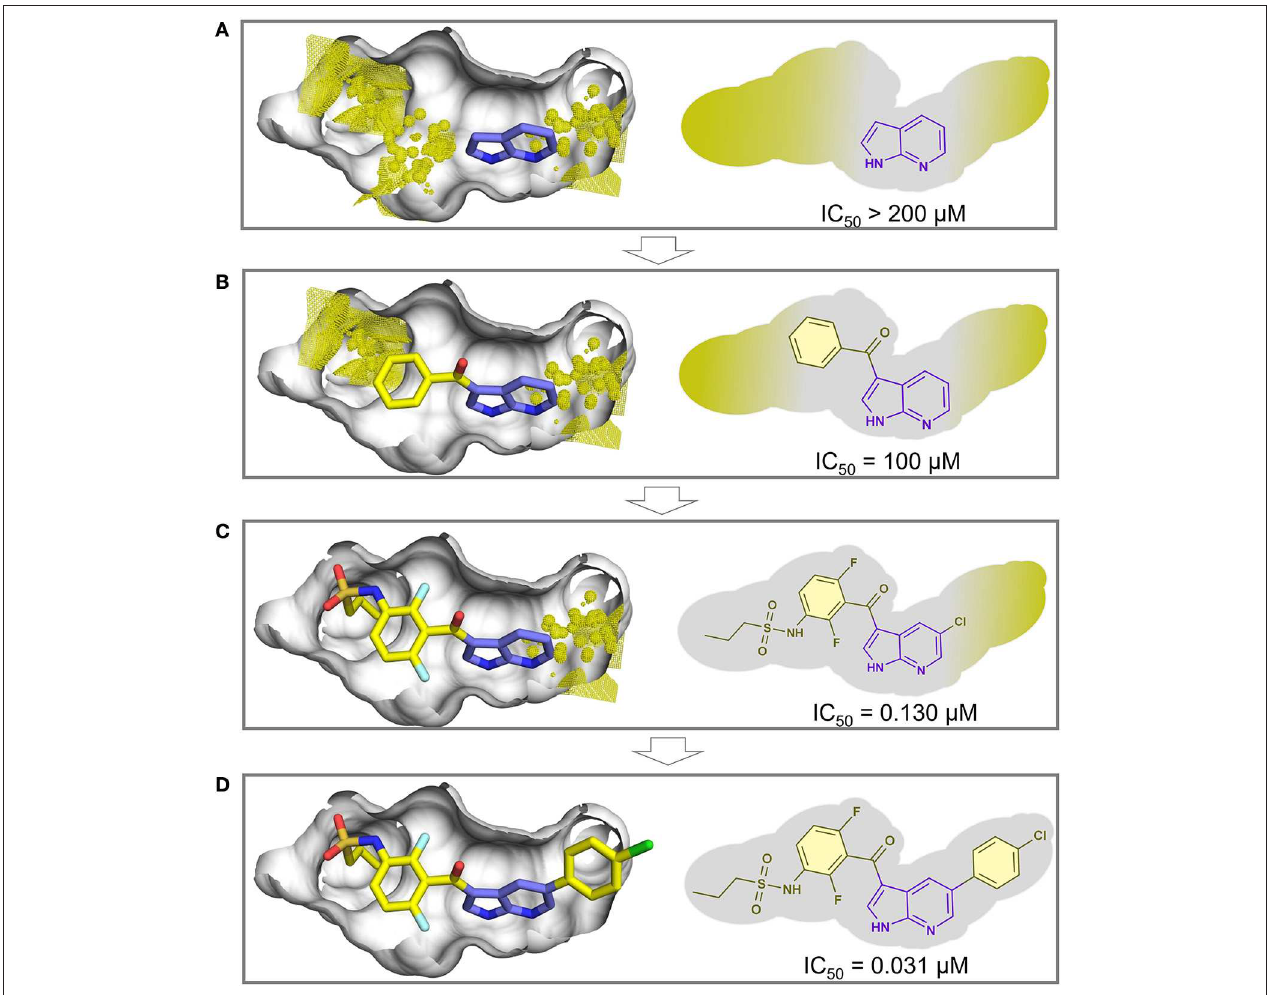
FIGURE 5 | Example of a hot spot analysis using FTMap web server of the oncogenic B-RAF kinase, the target of the first marketed drug from fragment-based drug design, vemurafenib. The surface of the binding site is depicted in gray. (A) (PDB ID: 2UVX) the fragment hit (carbon atoms in purple sticks) and the predicted hot spots (yellow dots and surface). (B–D) The iterative growing process of vemurafenib (PDB ID: 3OG7) overlapping the predicted hot spots (the carbon atoms of the fragment hit portion is shown in purple sticks and carbon atoms of the grown portions in yellow